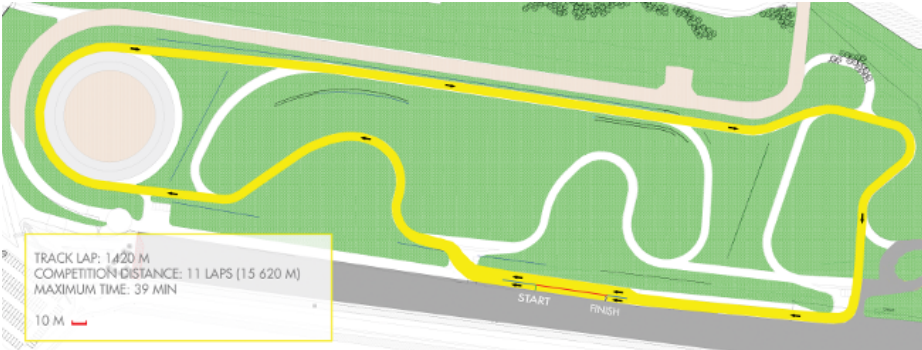
Figure 6. The track map of the Shell Eco-marathon Europe